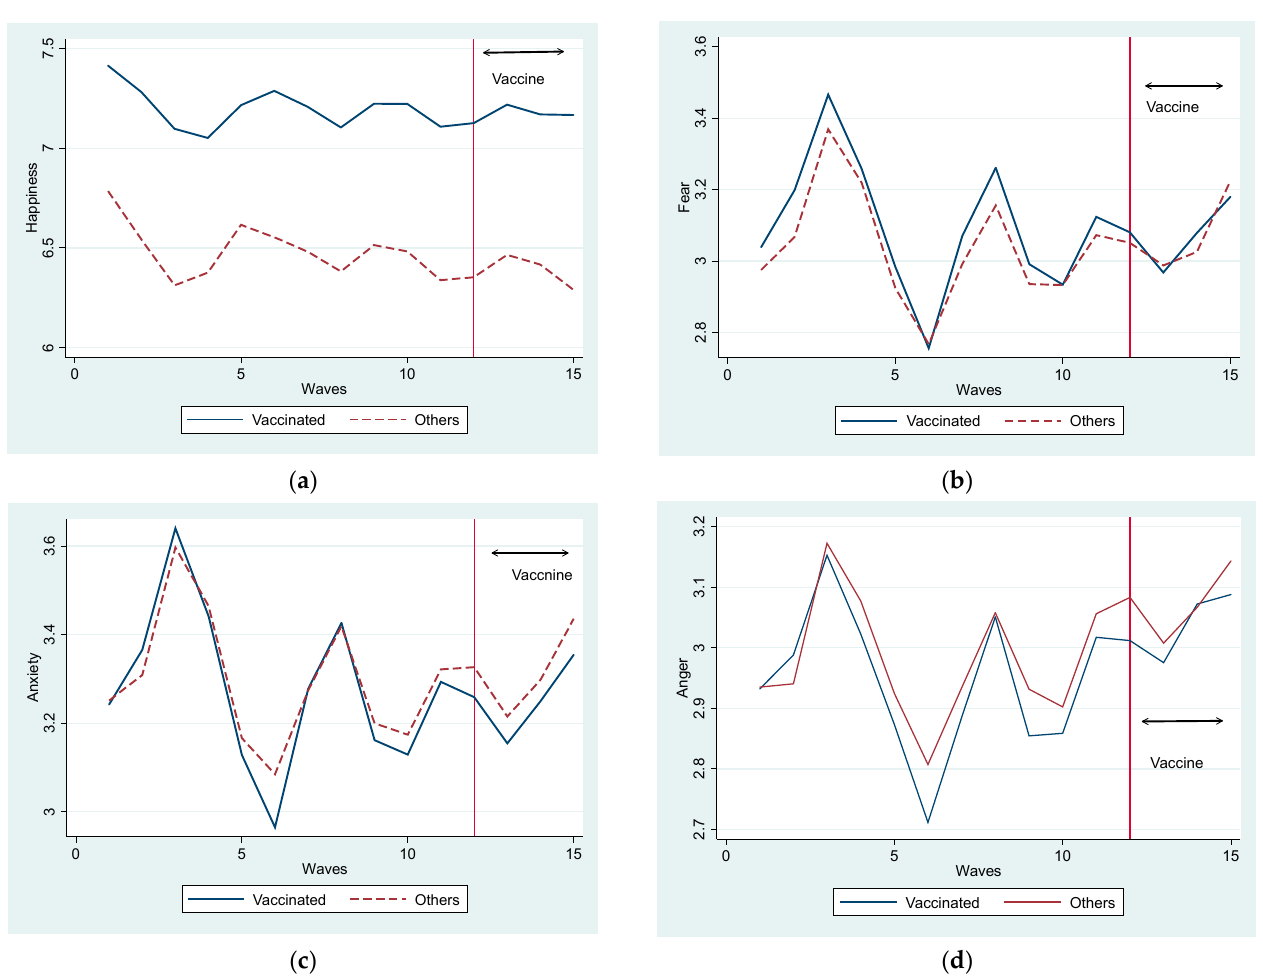
Figure 2. ( a ) Change in Happiness. ( b ) Change in Fear. ( c ) Change in Anxiety. ( d ) Change in Anger.